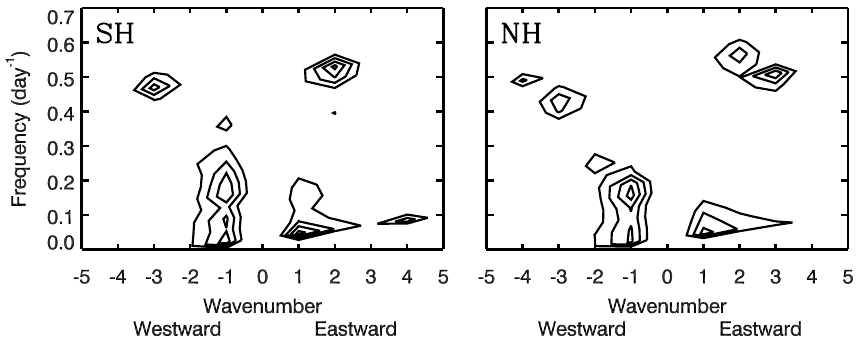
Fig. 1. The normalized mean frequency–wavenumber spectra of the temperature disturbances for different hemisphere. The minimum and interval of the contours are 0.65 and 0.1, respectively.